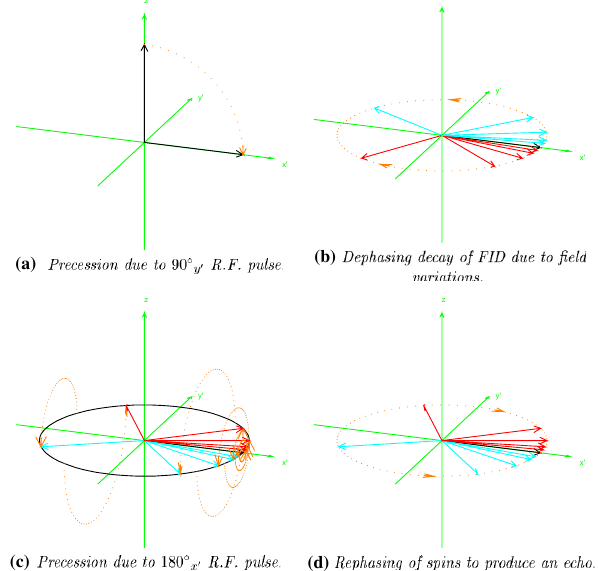
Fig. 3 Generation of a spin echo in an inhomogeneous magnetic field using a 90 ◦ y � − 𝜏 − 180 ◦ x � − 𝜏 − echo sequence, where the blue vectors are in a higher field than the red ones, and thus pre- cess faster